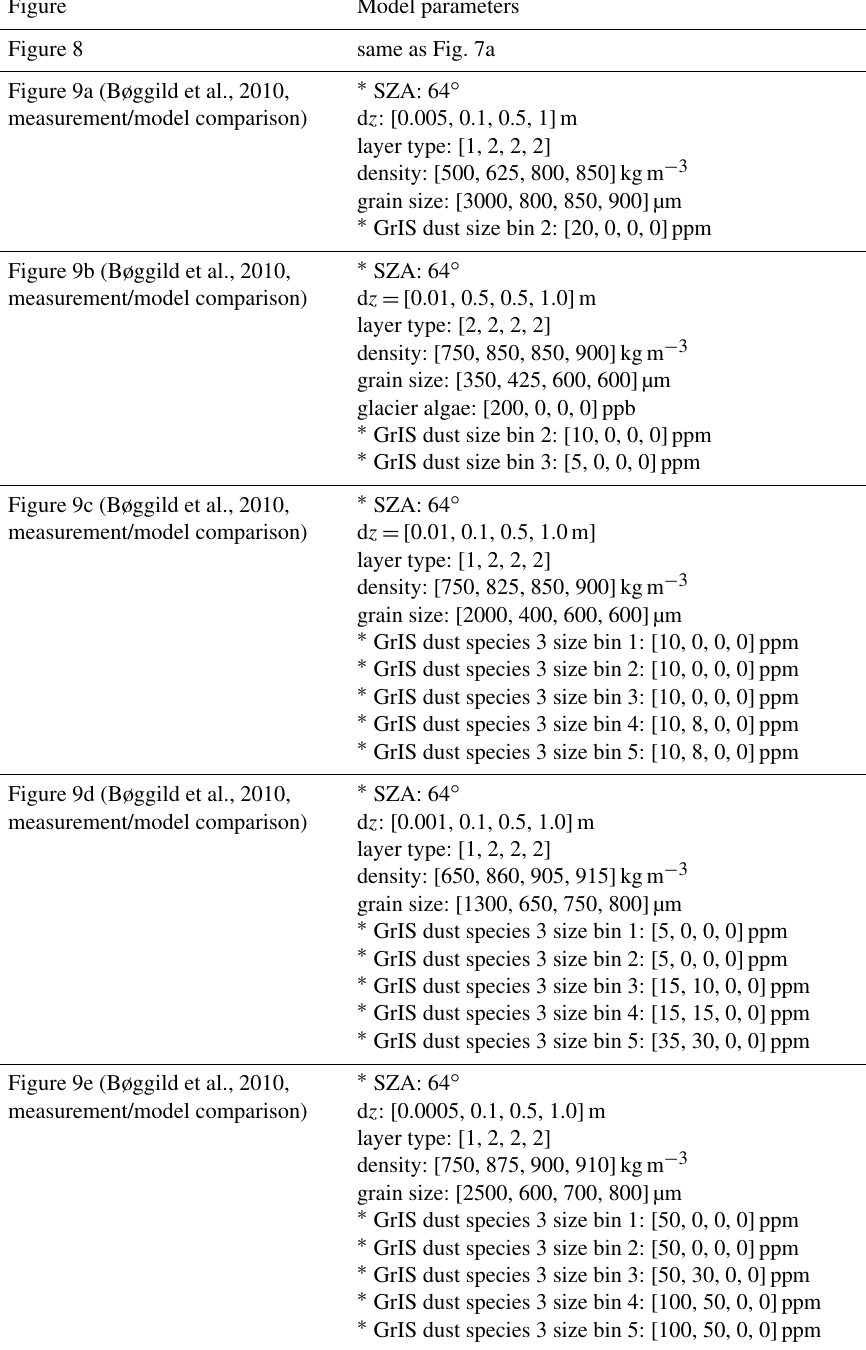
Table A1. Continued. Figure Model parameters Figure 8 same as Fig. 7a Figure 9a (Bøggild et al., 2010, measurement/model comparison)